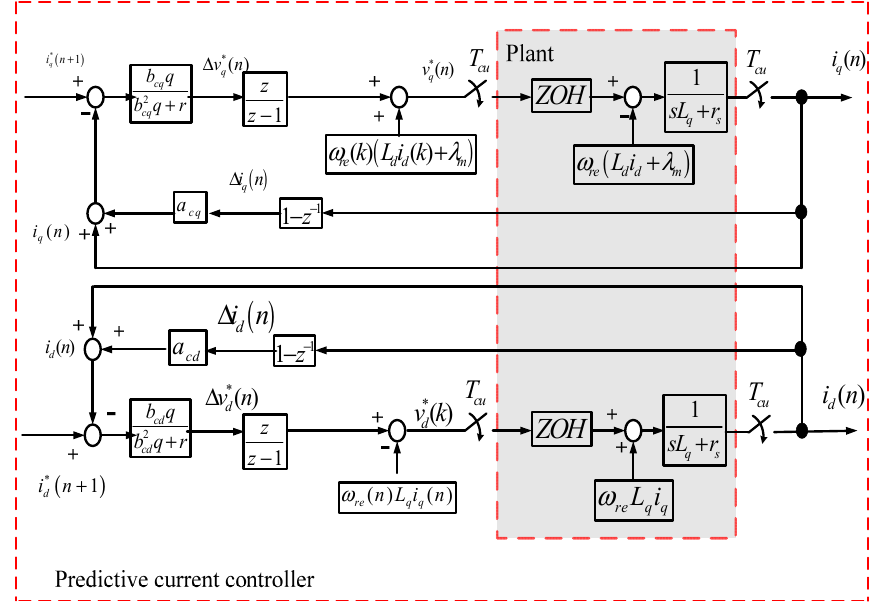
Figure 8. Current loop predictive controller.